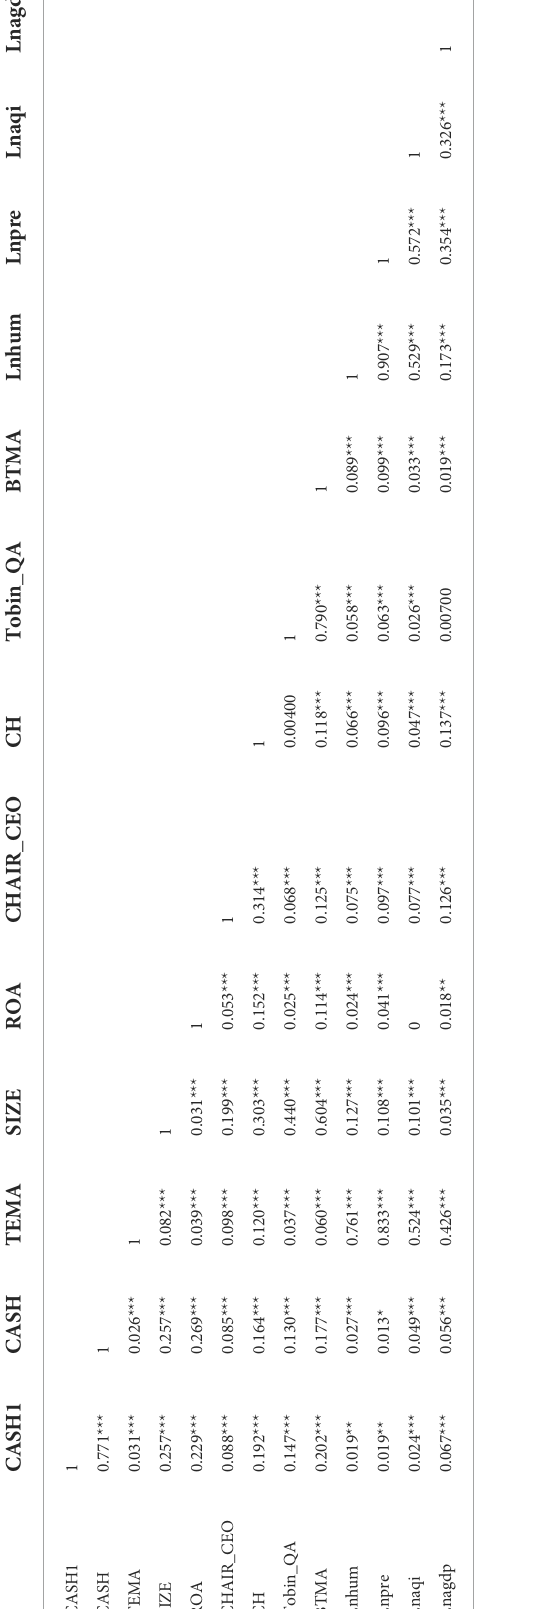
TABLE 4 Impact of climate change on the corporate cash holding